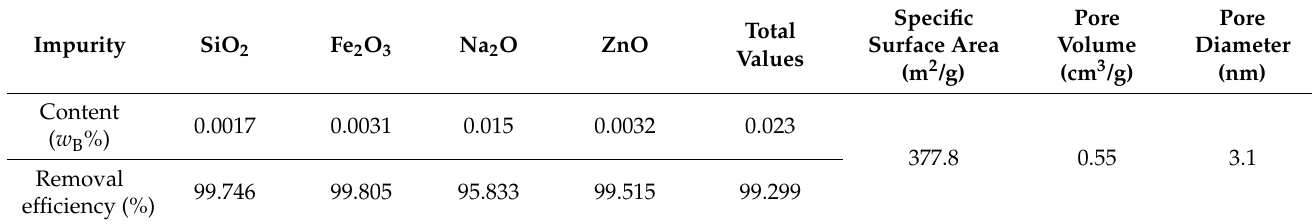
Table 8. Content of impurity in γ -Al 2 O 3 powder and its physical